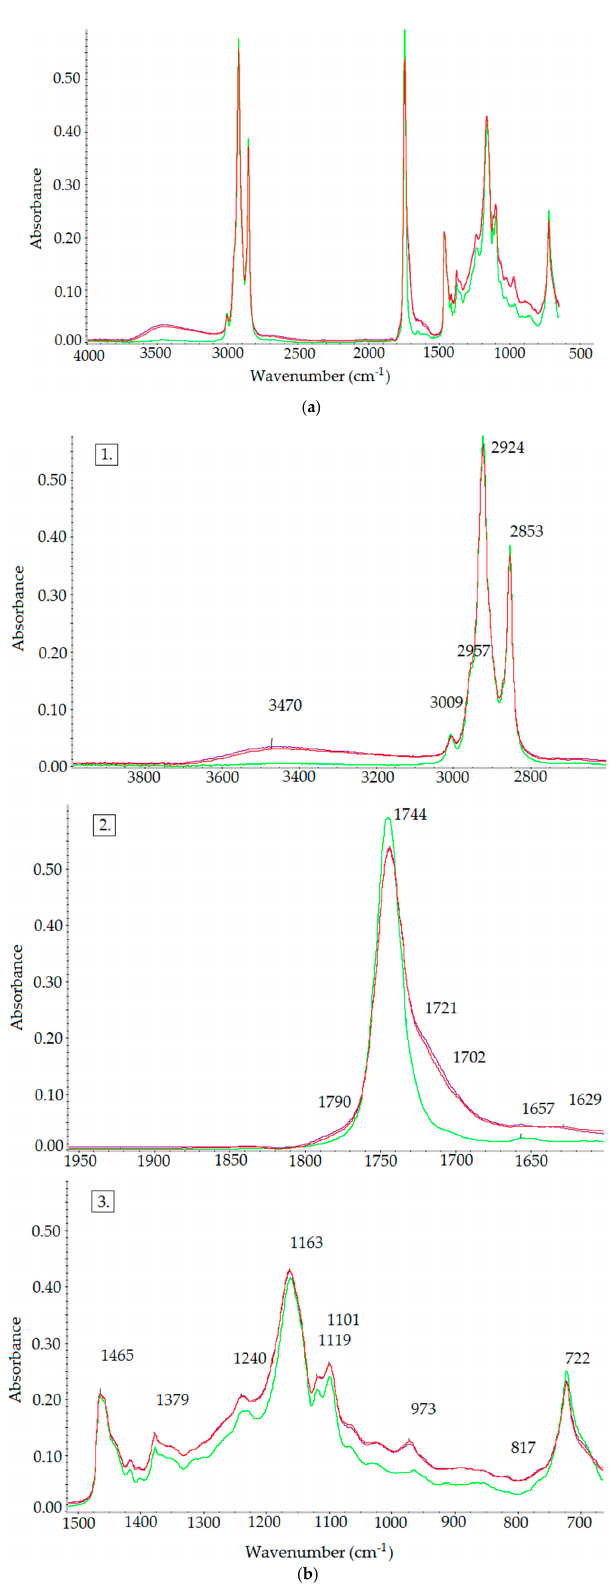
Figure 8. ( a ) ATR-FTIR spectra of oils: raw Crambe abyssinica oil A (green line), A_O 2 (red line), A_CO 2 (blue line). ( b ) ATR-FTIR spectra of oils: raw Crambe abyssinica oil A (green line), A_O 2 (red line), A_CO 2 (blue line): b1. In the region of 3800–2400 cm − 1 b2. In the region of 1950–1600 cm − 1 b3. In the region of 1500–650 cm − 1